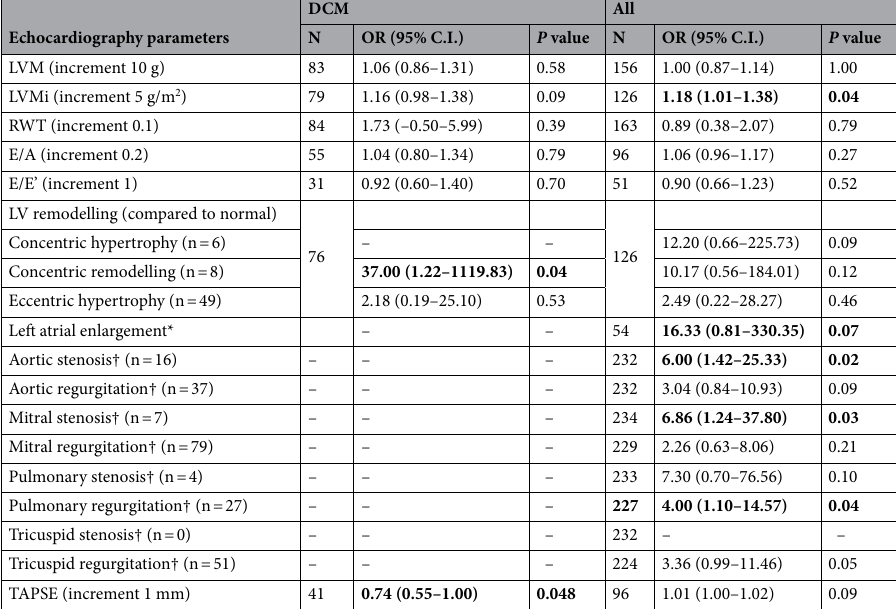
Table 4. Relationship between echocardiography parameters and pre-eclampsia prevalence. *Moderate left atrial enlargement compared with normal left atrial size. † Compared to none/physiological valvular regurgitation/stenosis. N describes the number of observations included in the analysis. n describes the number of pregnancies affected by the condition. Bold text indicates statistical significance ( p < 0.05). DCM Dilated cardiomyopathy, C.I. Confidence interval, LVM Left ventricular mass, LVMi LVM indexed to body surface area, RWT Relative wall thickness, E/A Early to late diastolic filling ratio, E/E’ Early diastolic filling to early diastolic mitral annular velocity ratio, LA Left atrium, TAPSE Tricuspid annular plane systolic excursion.